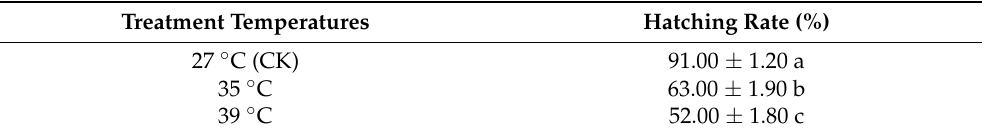
Table 2. Hatching rate of Leptinotarsa decemlineata after the adults were repeatedly exposed to different high temperature (27 ◦ C, 35 ◦ C and 39 ◦ C). Data are expressed as mean ± SE. Data followed by the same letter in the same column are not significantly different ( p > 0.05).